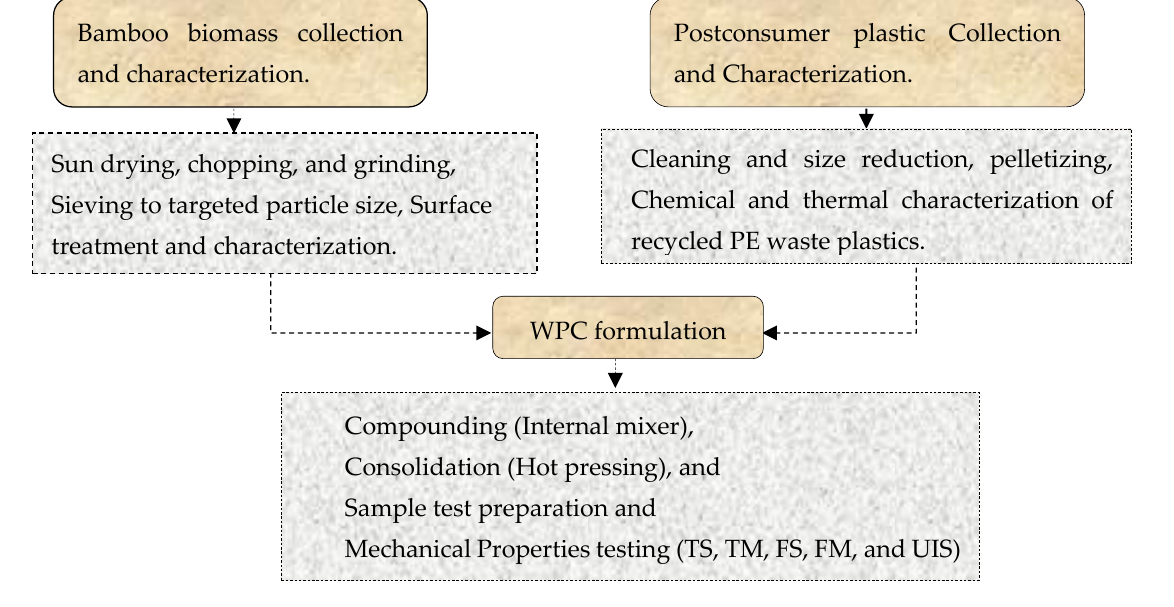
Figure 1. Experimental framework of the study.